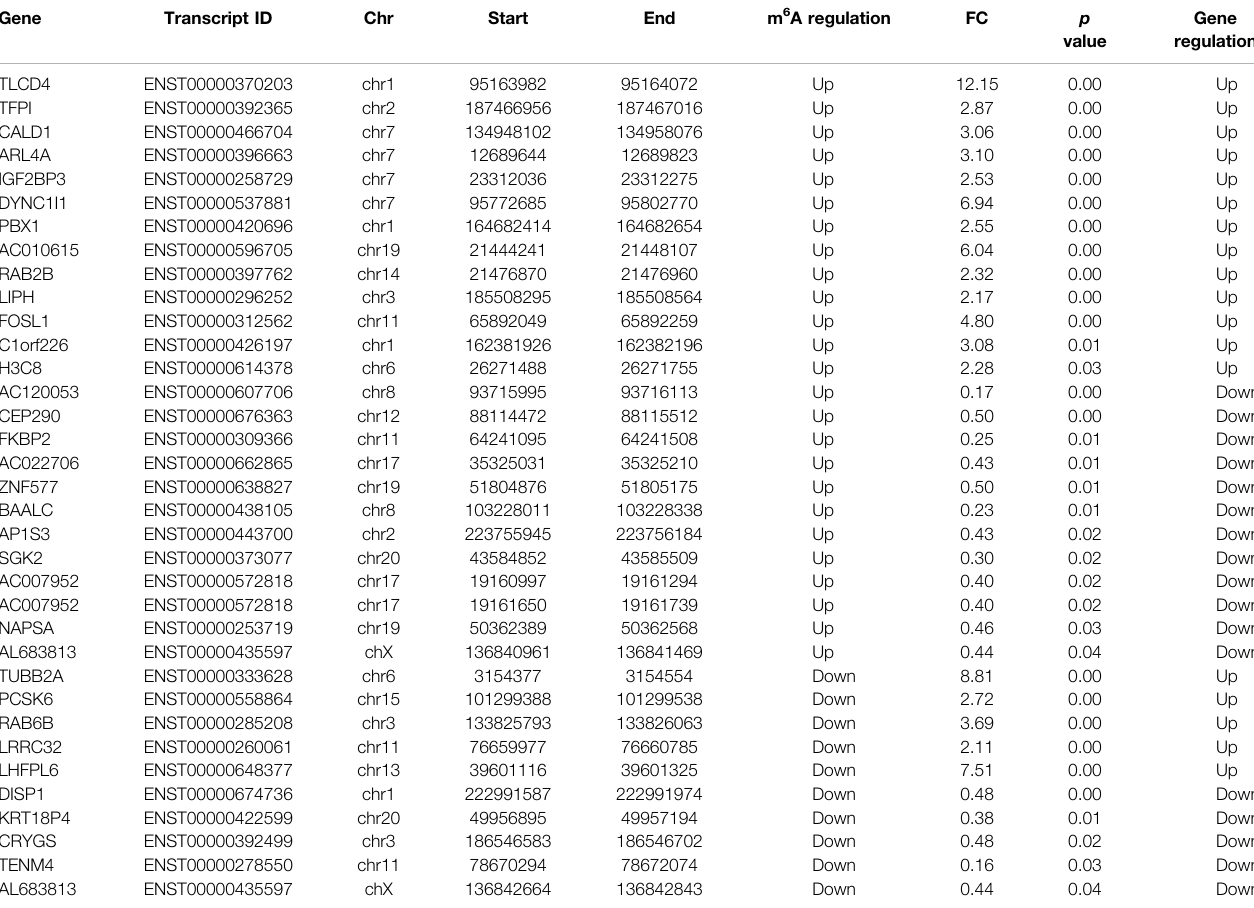
TABLE 2 | Differentially expressed genes with differentially methylated